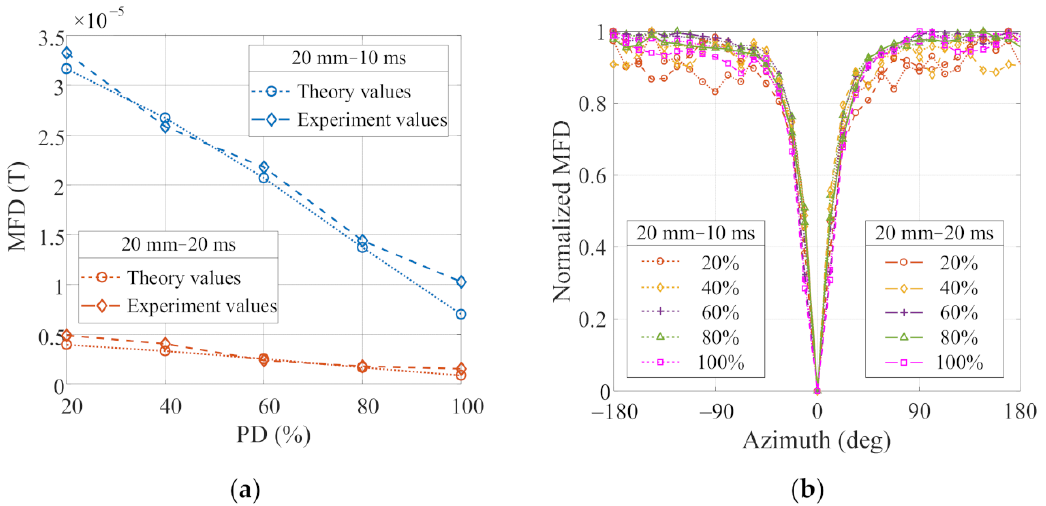
Figure 11. Comparison of the theoretical and experimental MFDs using the synthesized UCA for hole defects with different PDs at different sampling times: ( a ) Comparison of null values between the theoretical and experimental MFDs; ( b ) comparison of normalized MFDs with different PDs in the